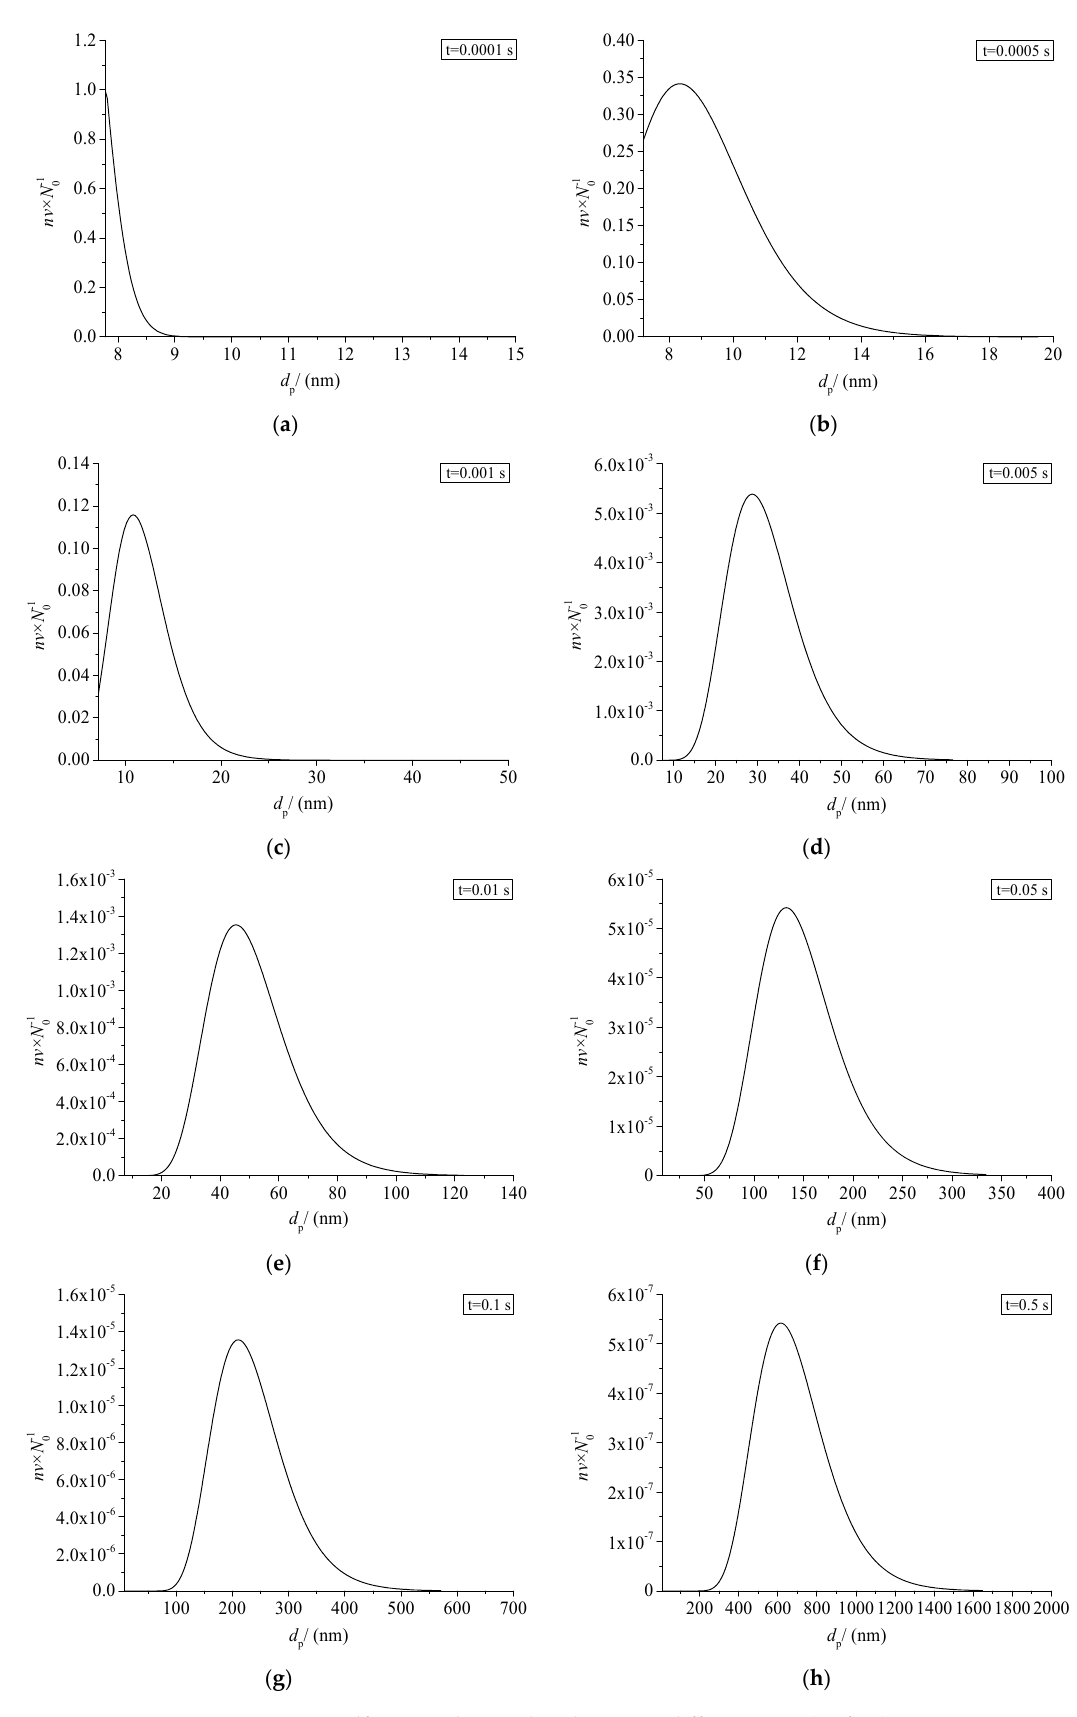
The variation of sulfur particle size distribution with the time is discussed in the pre- vious part. The nv / N 0 has a large variation range, as low as order of magnitude 10 − 7 at 0.5s. In order to further analyze the change of the proportion of sulfur particles of different sizes in the total number of sulfur particles at the same times, the curves of nv / N at differ- ent times after coagulation are drawn, as shown in Figures 20 and 21. For the convenience of observation, the abscissa of Figure 20 is the logarithmic axis, and the abscissa of Figure 21 is the conventional axis.